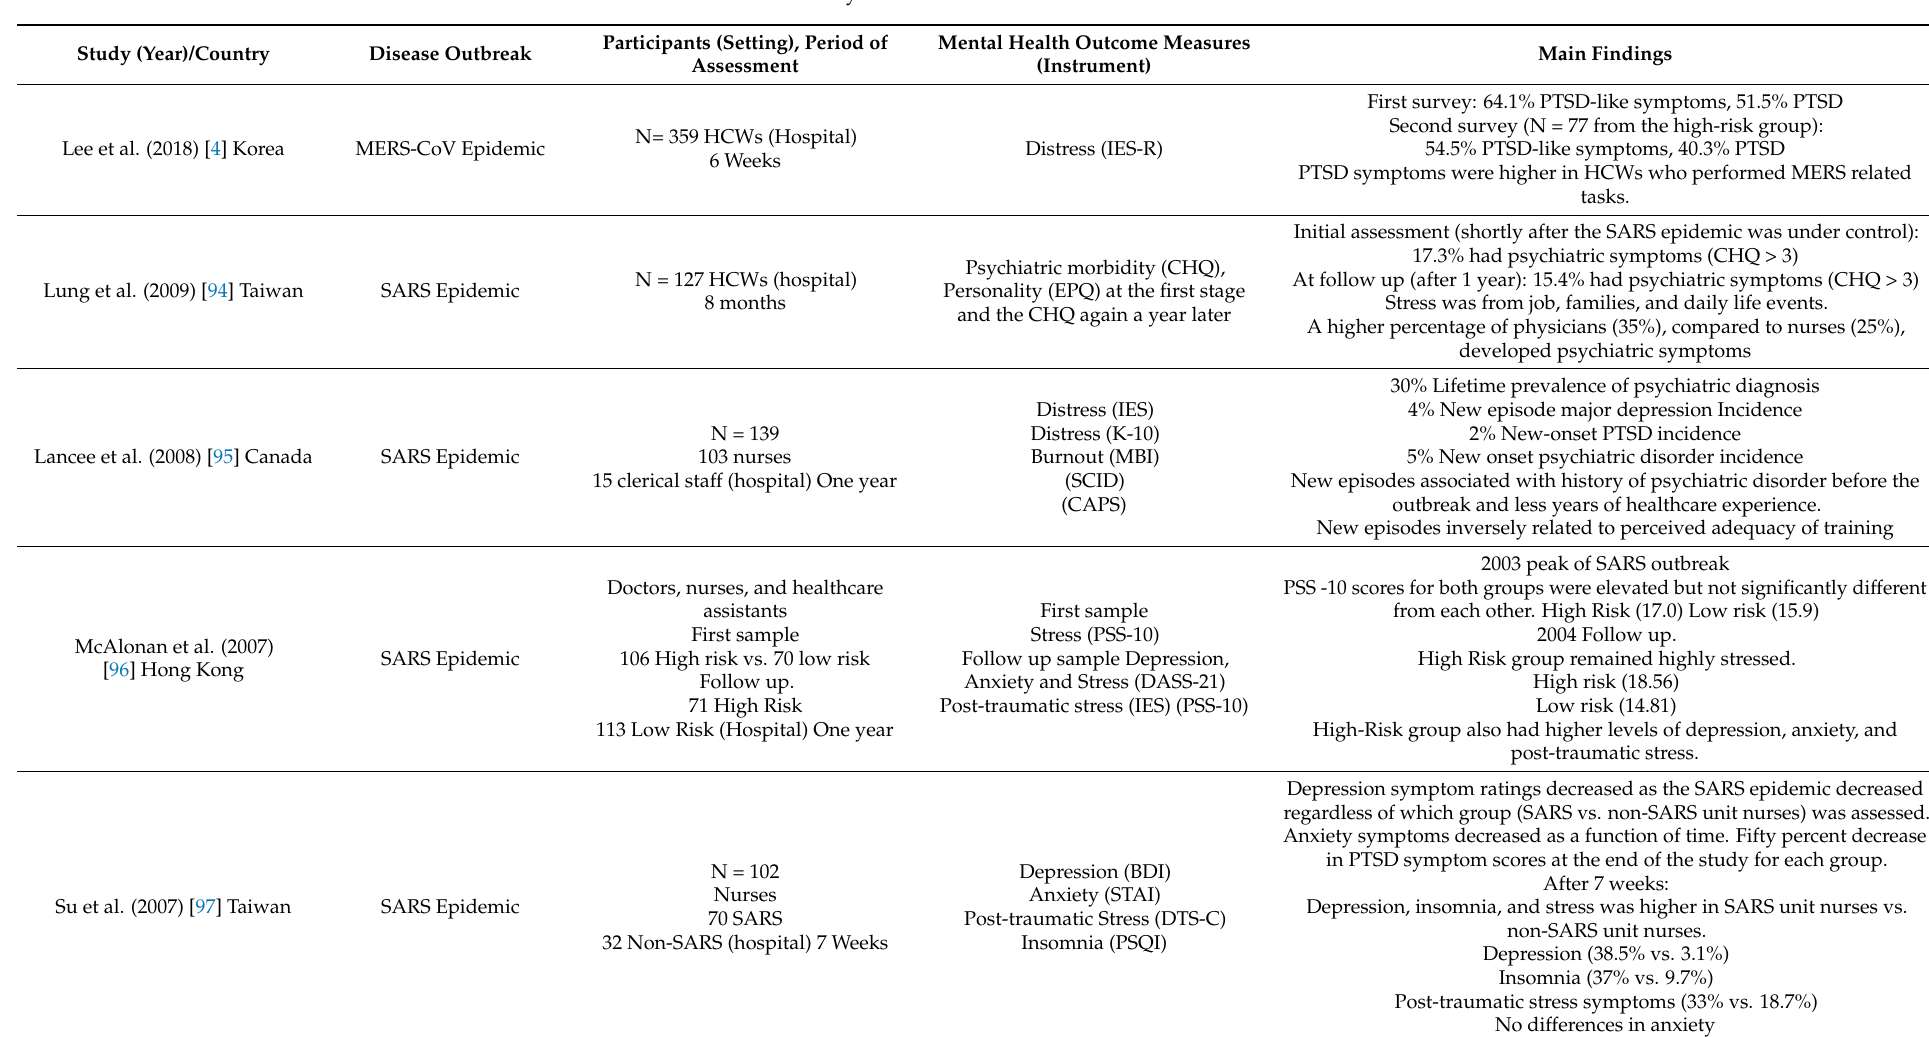
Table 2. A summary of the cohort studies included in this review.